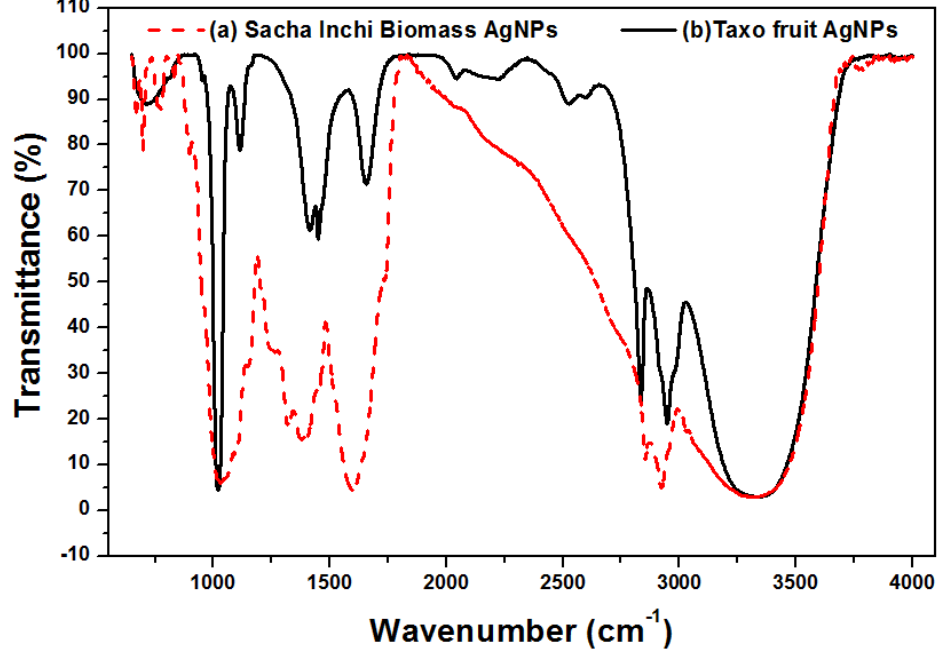
Figure 6. FTIR spectrum of silver nanoparticles synthesized using Taxo fruit and Sacha inchi shell biomass